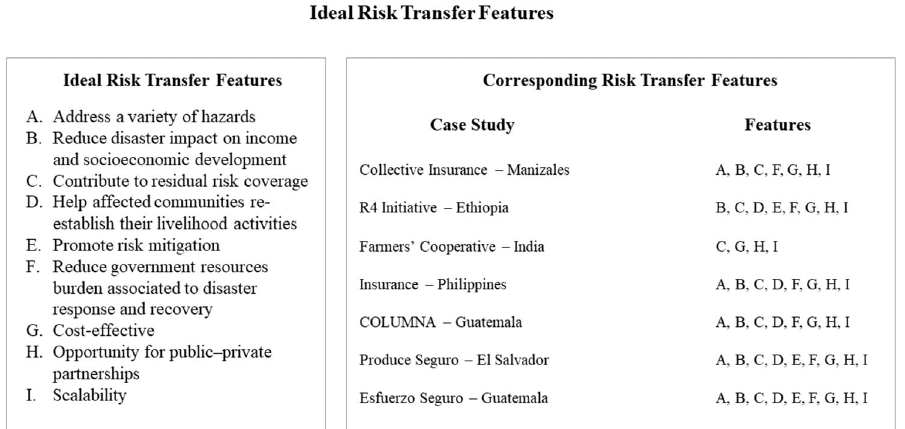
Fig. 1 Ideal risk